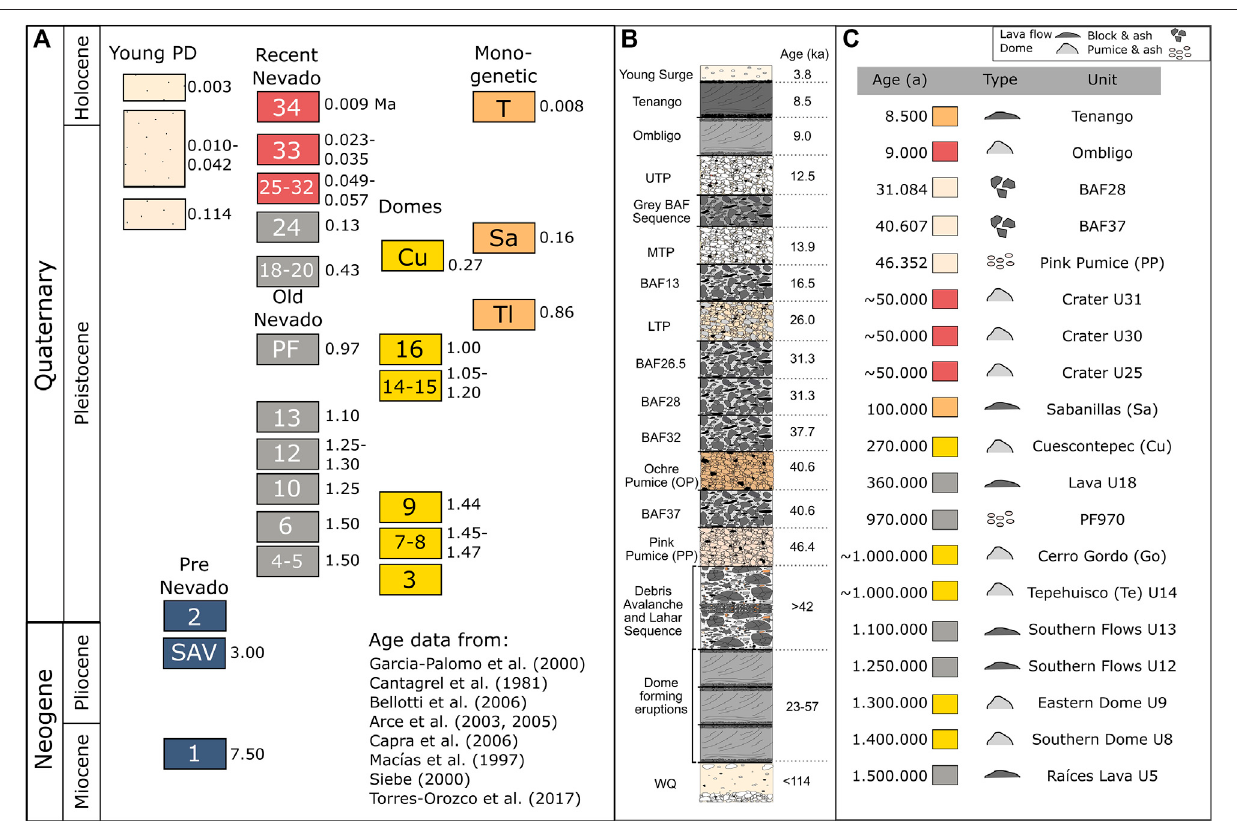
FIGURE 3 | Compilation of stratigraphic relations for Nevado de Toluca volcano. (A) Long-term stratigraphic relations and subdivision into groups modi fi ed after Torres-Orozco et al. (2017). Colors and abbreviations as in Fig. 2 . Age data have been compiled from Cantagrel et al. (1981), Macías et al. (1997), Garcia-Palomo et al. (2002),Siebe(2000),Arceetal.(2003),Arceetal.(2005),Bellottietal.(2006),Capraetal.(2006),andTorres-Orozcoetal.(2017). (B) Compositestratigraphiccolumnof the “ YoungPyroclastic Deposits (PD) ” sequence and “ RecentNevado ” groups. (C) Selection ofunits that have been analyzed from mineral chemistry in this